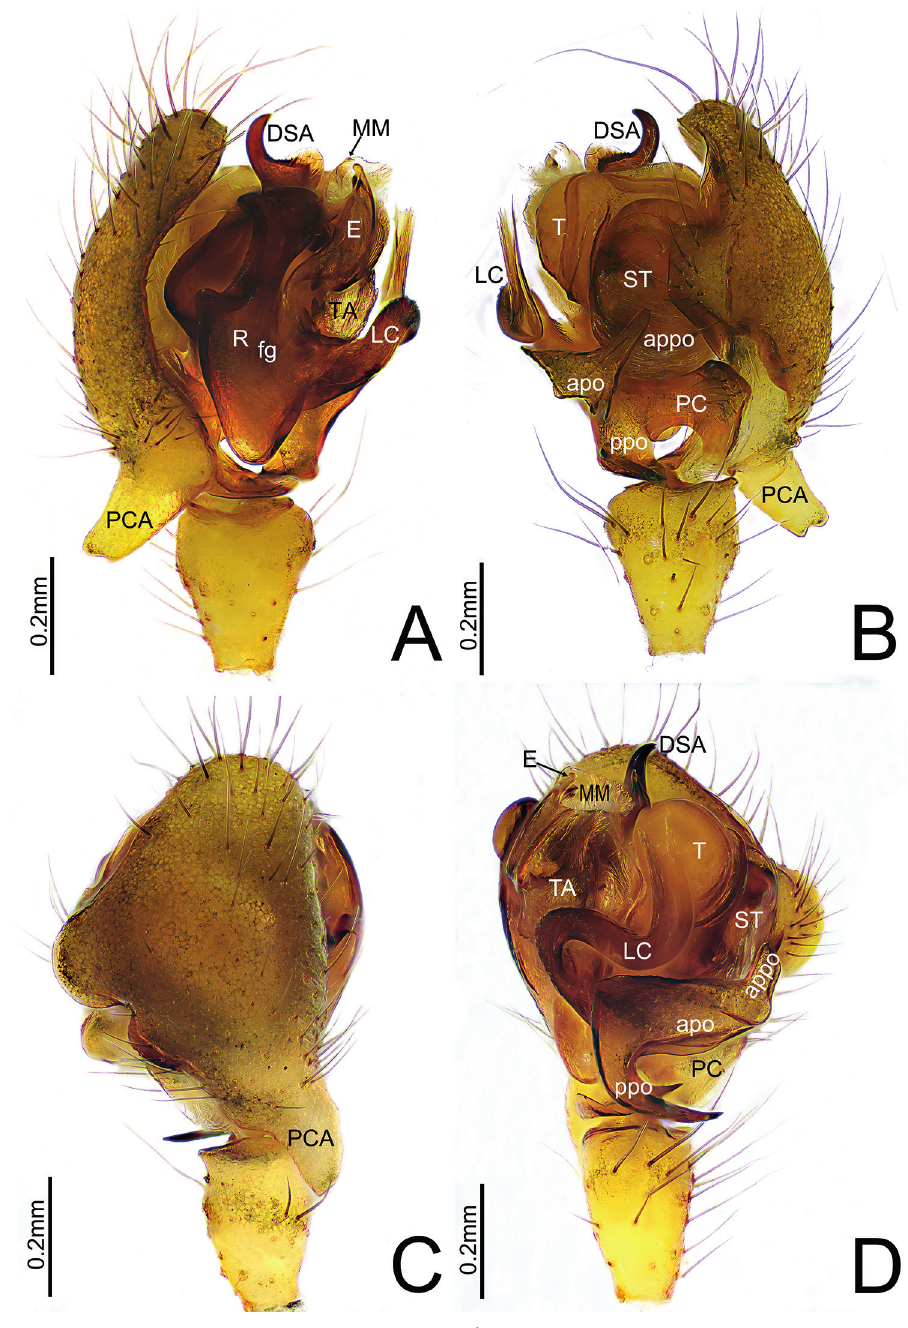
Figure 7. Himalaphantes uncatus sp. nov., holotype ♂ A palp, prolateral view B palp, retrolateral view C palp, dorsal view D palp, ventral